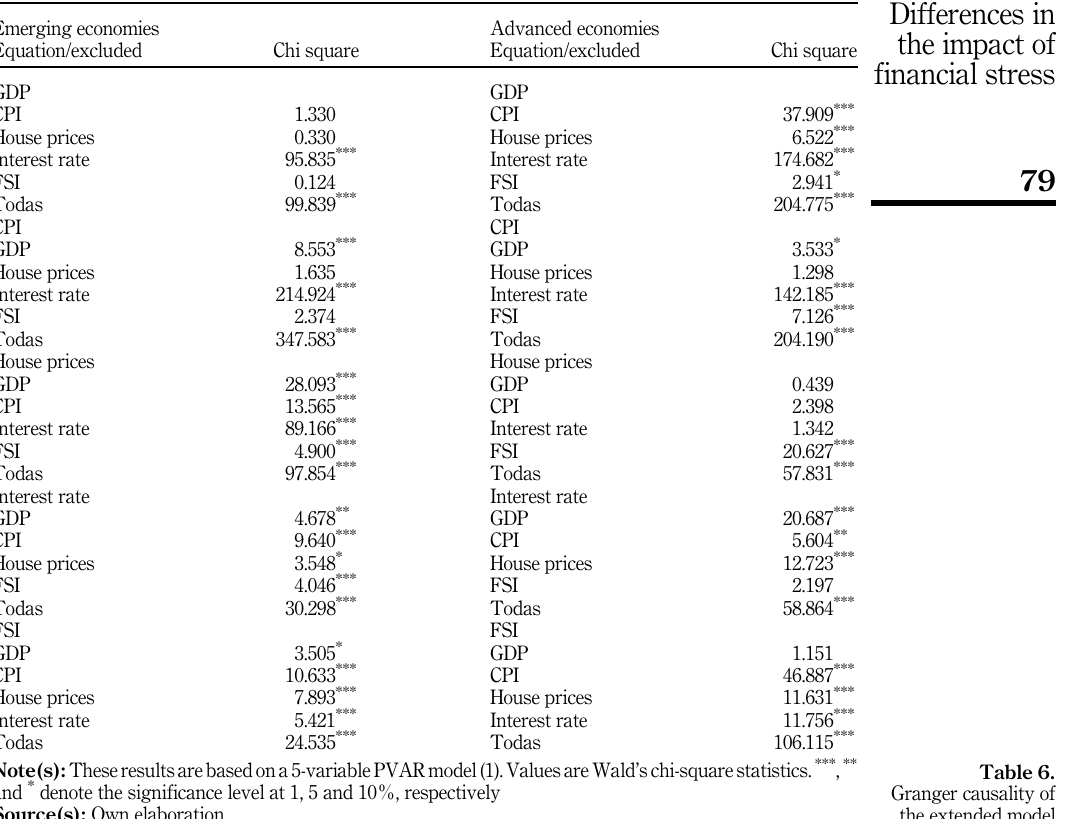
Table 6. Granger causality of the extended